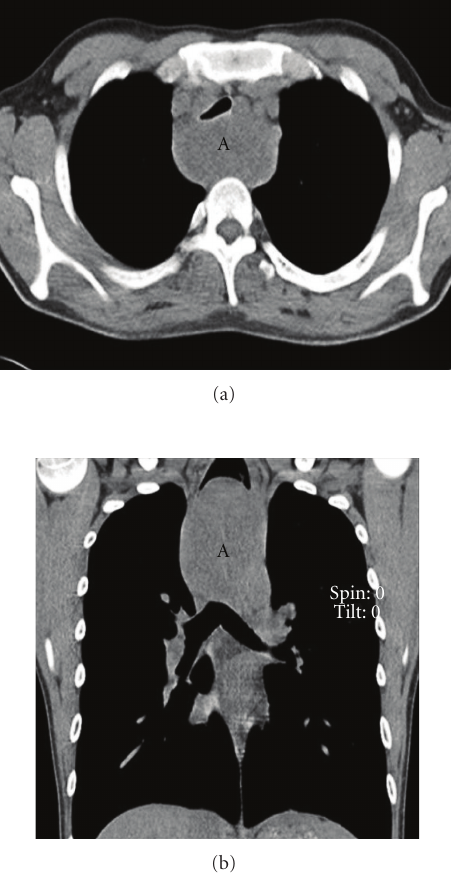
Figure 2: CT scan (a) with coronal view (b) showing large posterior mediastinal mass (A) with tracheal compression.